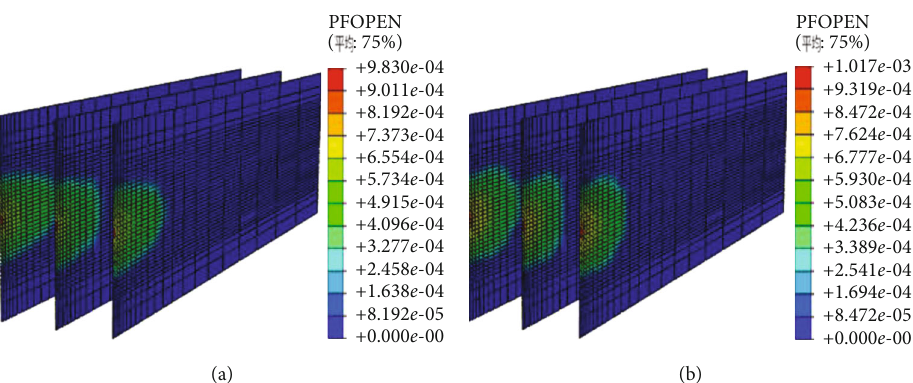
Figure 22: Fracture geometry after pumping for 50s for di ff erent fracturing fl uid viscosities: (a) case 8 (10 cp); (b) case 9 (100cp).